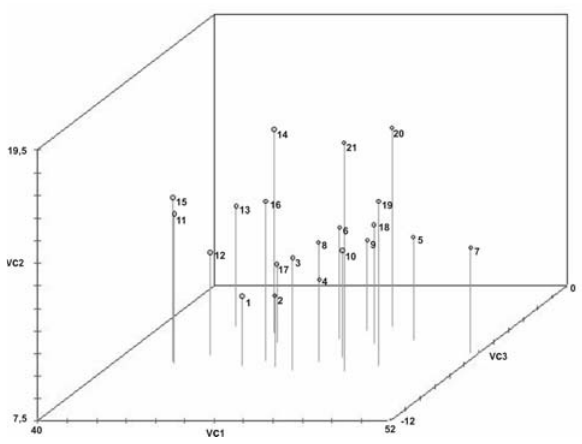
Figura 2. Gráfico de dispersão em relação às três primeiras variáveis canônicas (VC1, VC2 e VC3).